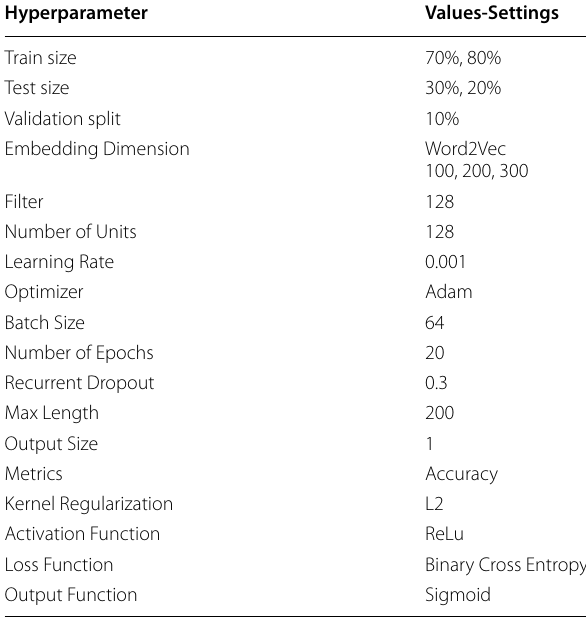
Table 6 Model parameter summary information Hyperparameter Values-Settings